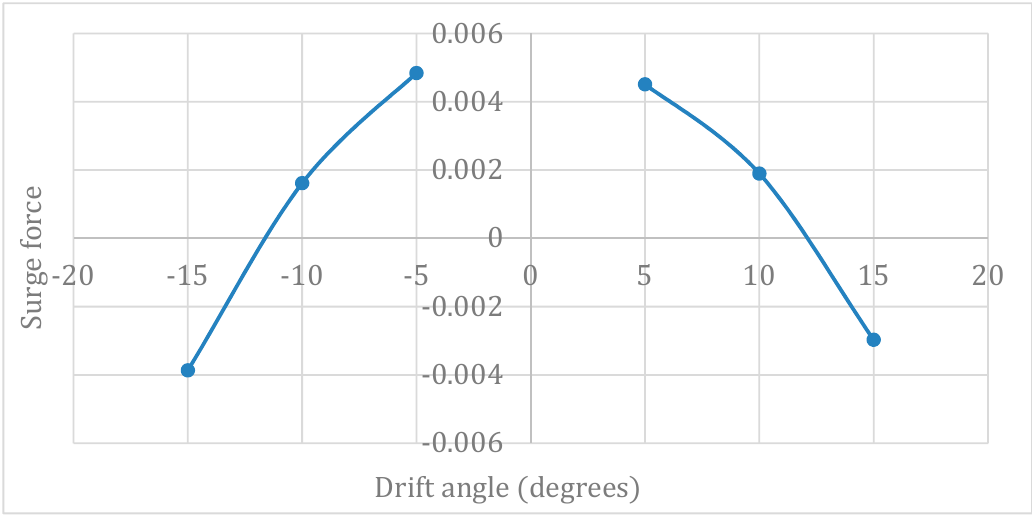
Figure 6. Vertical static drift calculation result for surge motion.